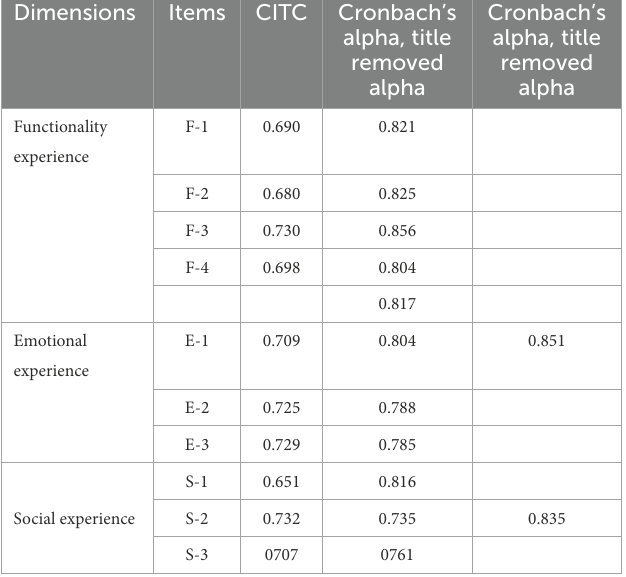
TABLE 4 Empirical scale reliability test table. Dimensions